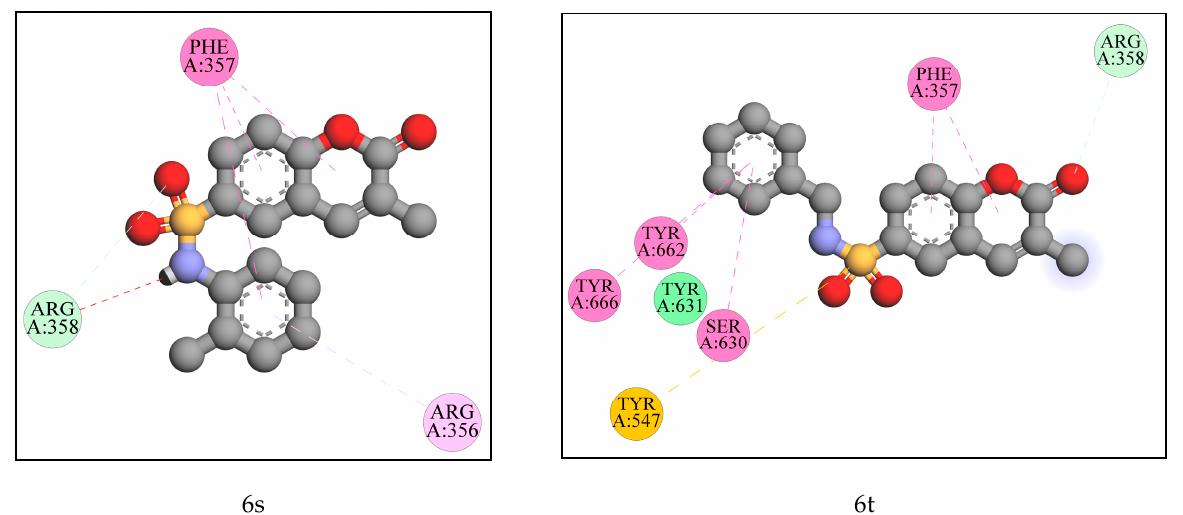
Figure 6. The molecular interactions of reference inhibitor and docked compounds which displayed less binding free energy than reference inhibitor.